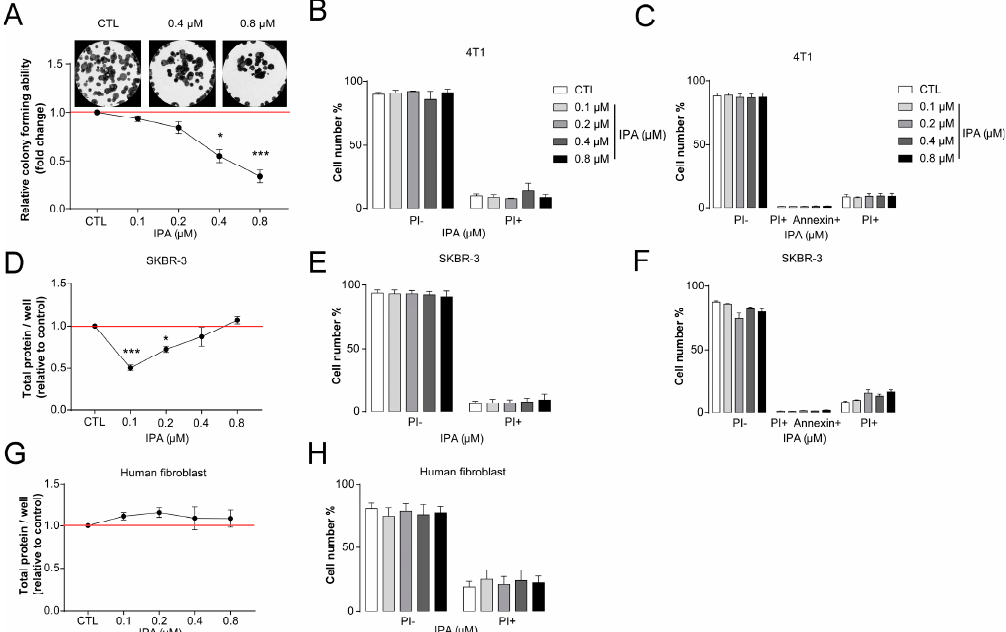
Figure 2. Indolepropionic acid (IPA) reduces cell proliferation in cellular models of breast cancer. ( A ) 500 cells/well 4T1 cells were seeded in 6-well plates and then treated with IPA in the concentrations indicated for 7 days. Then, colonies were stained according to May–Grünwald–Giemsa and analyzed using the ImageJ software ( n = 3). ( B ) 4T1 cells were seeded in 6-well plates (75,000 cells/well) and treated with the indicated concentrations of IPA for 24 h and stained with propidium-iodide; then, they were analyzed by flow cytometry. ( C ) 4T1 cells (75,000 cells/well in 6-well plates) were treated with IPA in the concentrations indicated for 24 h; the ratio of necrotic and apoptotic cells were determined with staining by propidium–iodide–FITC Annexin double staining using the V/Dead Cell Apoptosis Kit and measured by flow cytometry ( n = 3). ( D ) SKBR-3 (5000 cells/well) were seeded in 96-well plates and then were treated with IPA in the concentrations indicated for 24 h; then, total protein content was assessed in sulforhodamine B (SRB) assays ( n = 3). ( E ) SKBR-3 (200,000 cells/well) cells were seeded in 6-well plates and were treated with IPA in the concentrations indicated for 24 h. The ratio of necrotic and apoptotic cells were determined with staining by propidium–iodide; then, they were analyzed by flow cytometry. ( F ) SKBR-3 (200,000 cells/well) cells were seeded in 6-well plates and were treated with IPA in the concentrations indicated for 24 h. The ratio of necrotic and apoptotic cells were determined with staining by propidium–iodide–FITC Annexin double staining using the V/Dead Cell Apoptosis Kit and measured by flow cytometry ( n = 3). ( G ) Human fibroblast (7500 cells/well) cells were seeded in 96-well plates and then were treated with IPA in the concentrations indicated for 24 h; then, the total protein content was assessed in SRB assays ( n = 3). ( H ) Human fibroblast (20,000 cells/well) cells were seeded in 6-well plates and then were treated with IPA in the concentrations indicated for 24 h. Then, the ratio of necrotic and apoptotic cells were determined with staining by propidium–iodide and analyzed by flow cytometry ( n = 3). Fold data were log2 transformed to achieve normal distribution. Statistical significance was determined using ANOVA test followed by Tukey’s post-hoc test, except for panels D, E, and F, where Dunnett’s post-hoc tests were conducted. * or *** indicate statistically significant difference between control and treated samples at p < 0.05 or p < 0.001, respectively.